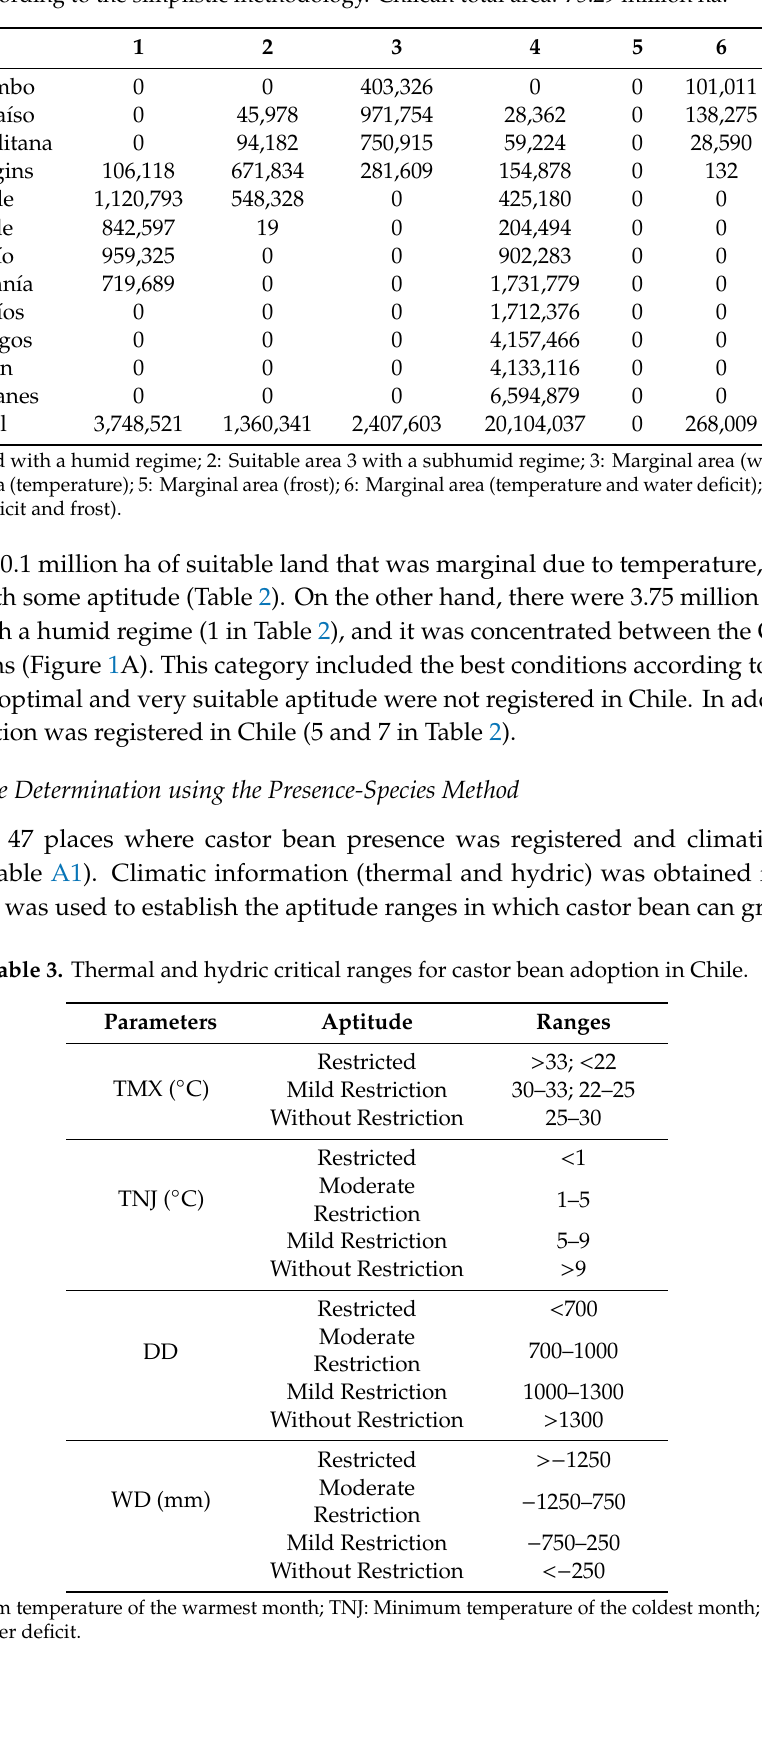
Table 2. Regional surface area with climatic aptitude for castor bean production as a national oil-seed crop (ha), according to the simplistic methodology. Chilean total area: 75.29 million ha.